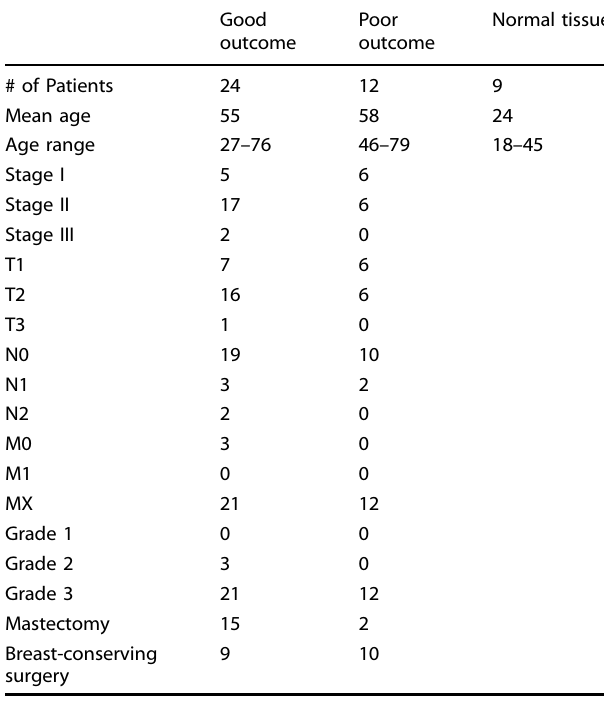
Table 1. Clinicopathological characteristics of patients with